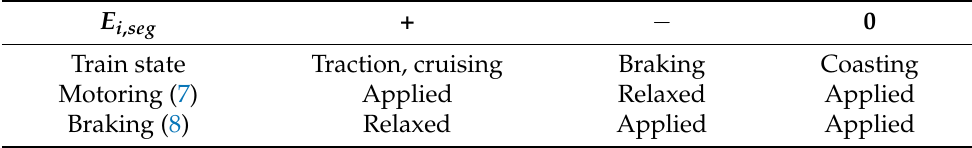
Table 2. Different values of E i , seg and their corresponding train